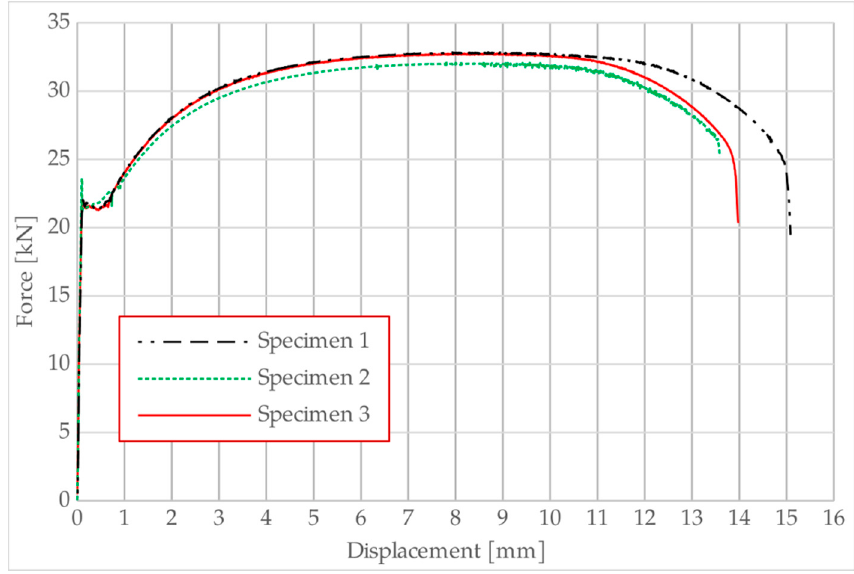
Figure 10. Force–displacement response of experimentally investigated S355J2+N steel specimens.